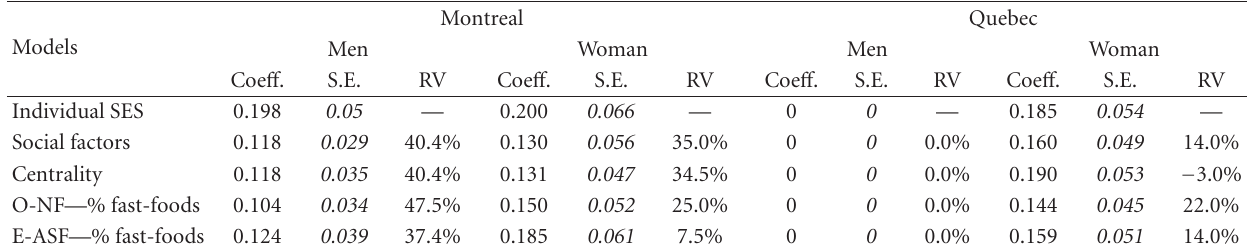
Table 4: Territorial variance of overweight for men and women in Montreal and Quebec City.